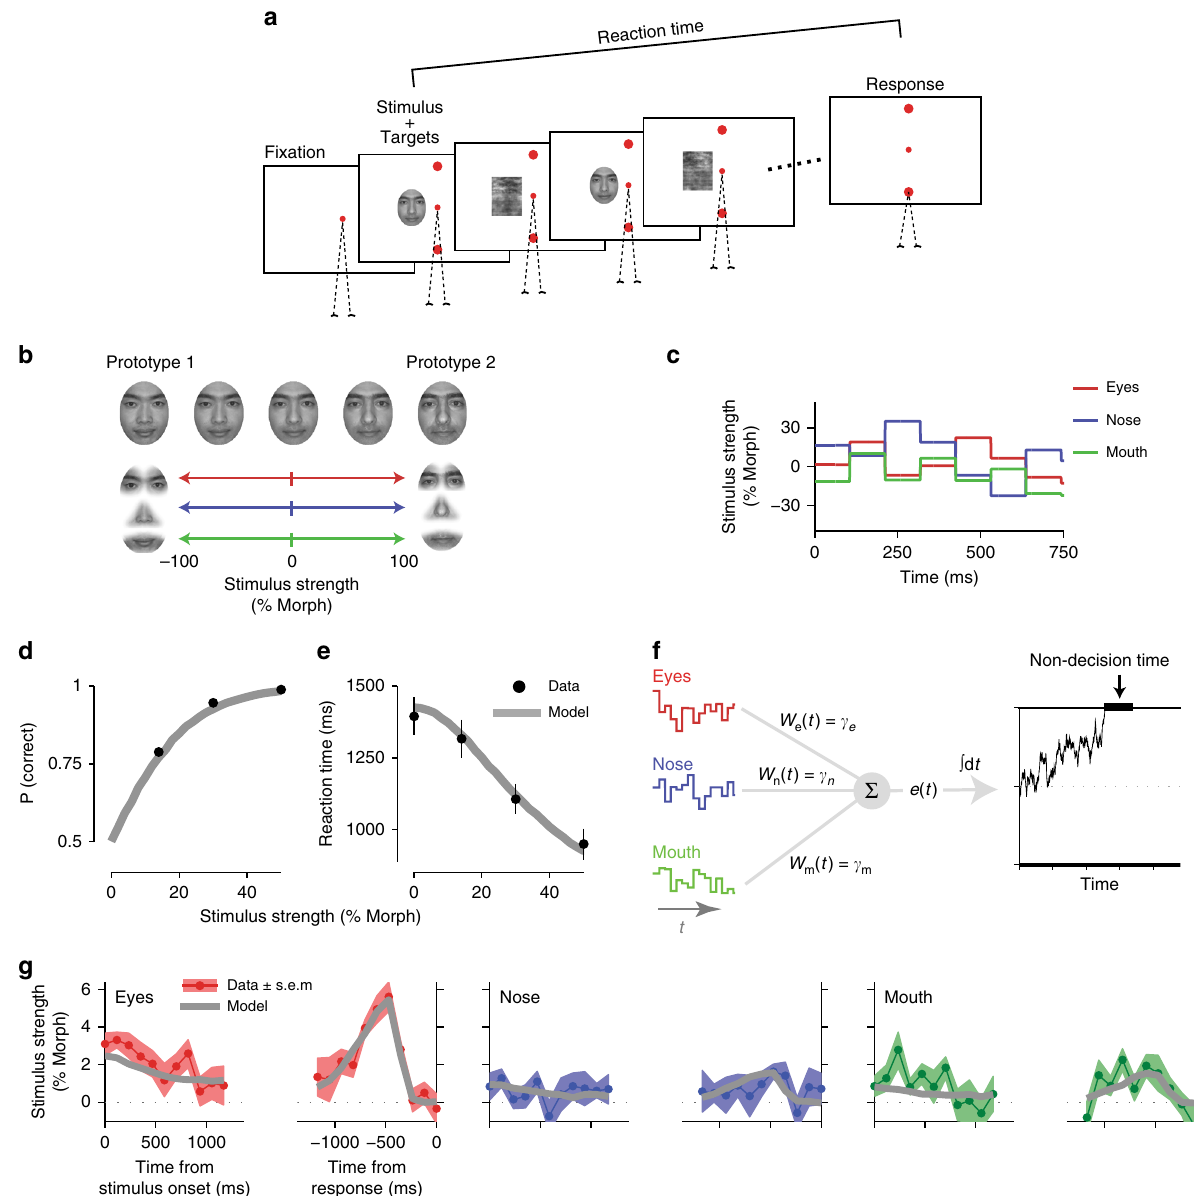
Fig. 5 Psychophysical reverse correlation in a face discrimination task with multiple informative features reveals relative weighting of features and kernel dynamics similar to the direction discrimination task. a Task design. Subjects viewed a sequence of faces interleaved with masks and reported whether the face identity matched one of two prototypes. They reported their choice with a saccadic eye movement to one of the two targets, as soon as ready. b Using a custom algorithm, we designed intermediate morph images between the two prototype faces such that only three facial features (eyes, nose, and mouth) could be informative. These features were morphed independently from one prototype ( + 100% morph) to another ( − 100% morph), enabling us to create stimuli in which different features could be biased toward different identities. All regions outside the three informative features were set to halfway between the prototypes and were uninformative. c The three informative features underwent subliminal fl uctuations within each trial (updated with 106.7- ms interval). The mean morph levels of the three features were similar but varied across trials. Fluctuations of the three features were independent (Gaussian distribution with standard deviations set to 20% morph level). d , e Choice accuracy increased and RTs decreased with stimulus strength. Data points are averages across nine subjects. Error bars are s.e.m. across subjects. Gray lines are model fi ts. f The DDM used to fi t subjects ’ choices and RTs extends the model in Fig. 2 by assuming different sensitivity for the three informative features. Momentary evidence is a weighted average of three features where the weights correspond to the sensitivity parameters. The momentary evidence is integrated toward a decision bound. g Psychophysical kernels estimated from the model (gray lines) match subjects ’ kernels for the three features. Shaded areas are s.e.m. across